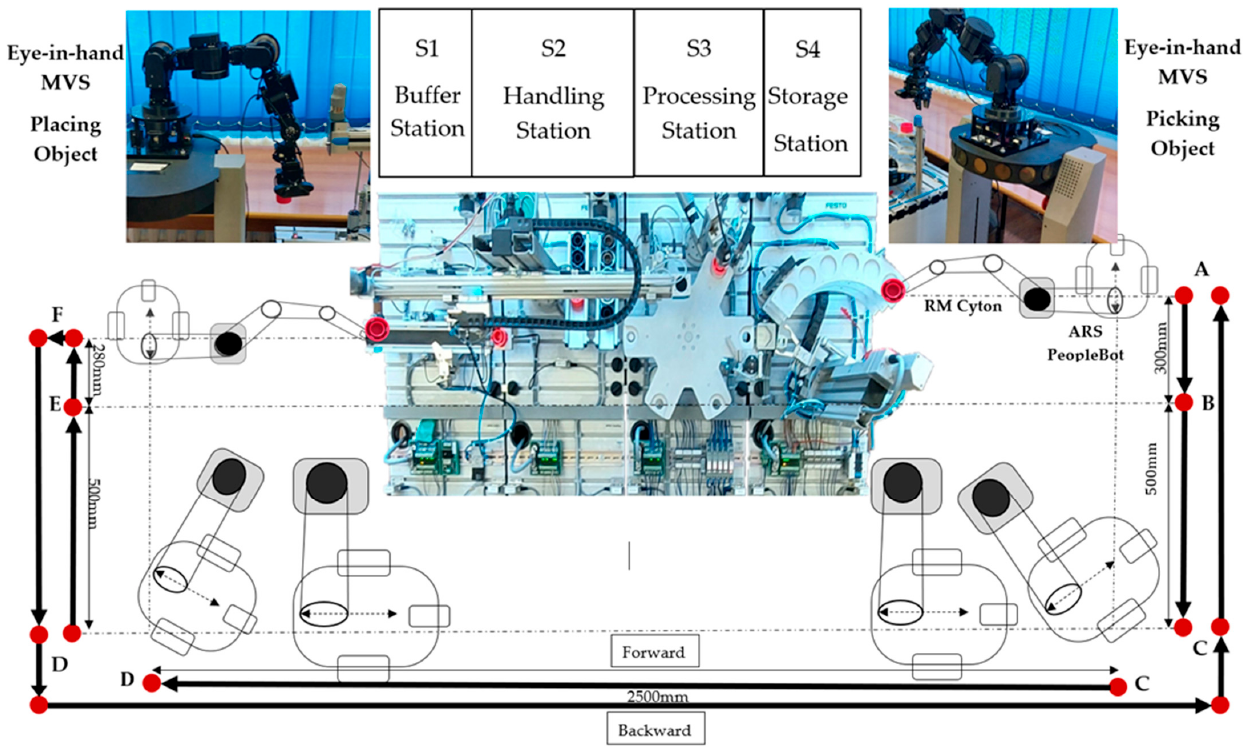
Figure 3. P/RML assisted by CAS.